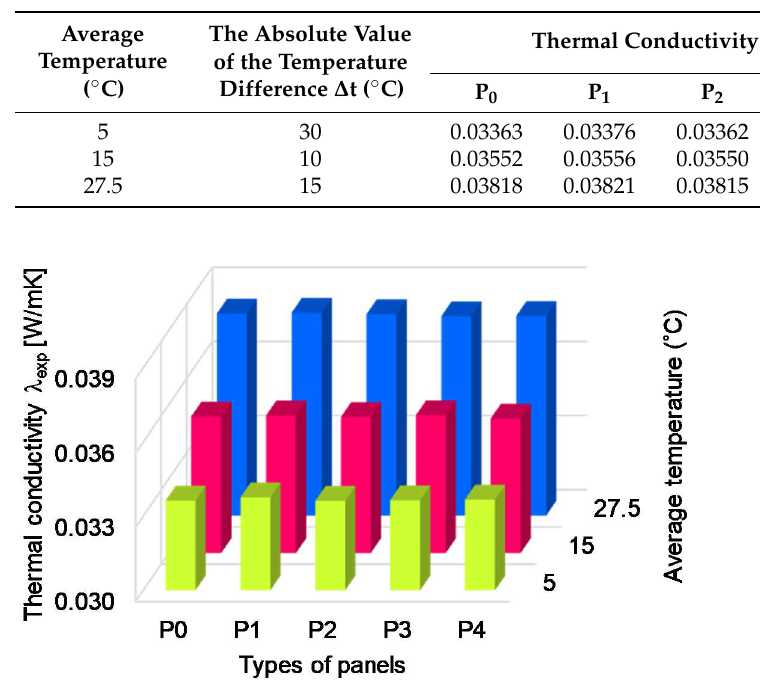
Figure 9. Variation of thermal conductivity of panels obtained from experiments as a function of the channels’ arrangement and temperature regime.